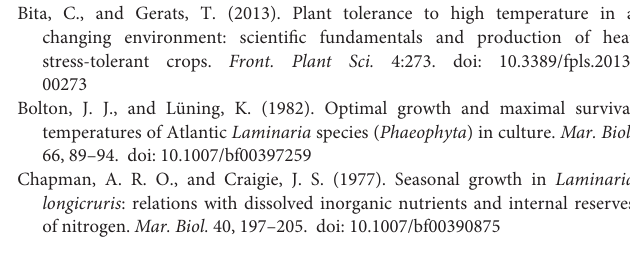
Supplementary Figure 1 | Photographs of E. bicyclis juvenile sporophytes cultured at 23 ◦ C (A,C,E,G) and 26 ◦ C (B,D,F,H) combined with two nutrient levels and two irradiance levels in the experiment 1. N − (A,B,E,F) and N + (C,D,G,H) indicate non-enriched and enriched treatments, respectively. I − (A–D) and I + (E–H) indicate low and high irradiance treatments,